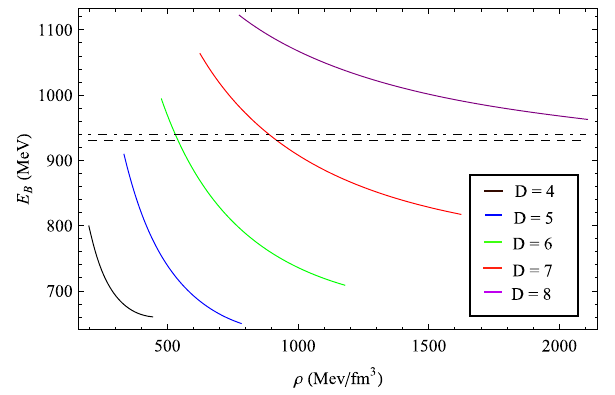
Fig. 18 Variation of energy per baryon ( E B ) with density ( ρ ) for EXO1745-248. Here the dashed line represents energy per baryon of 56 Fe which is 930.4 MeV and dot dashed line corresponds to the mass of nucleons (939 MeV)